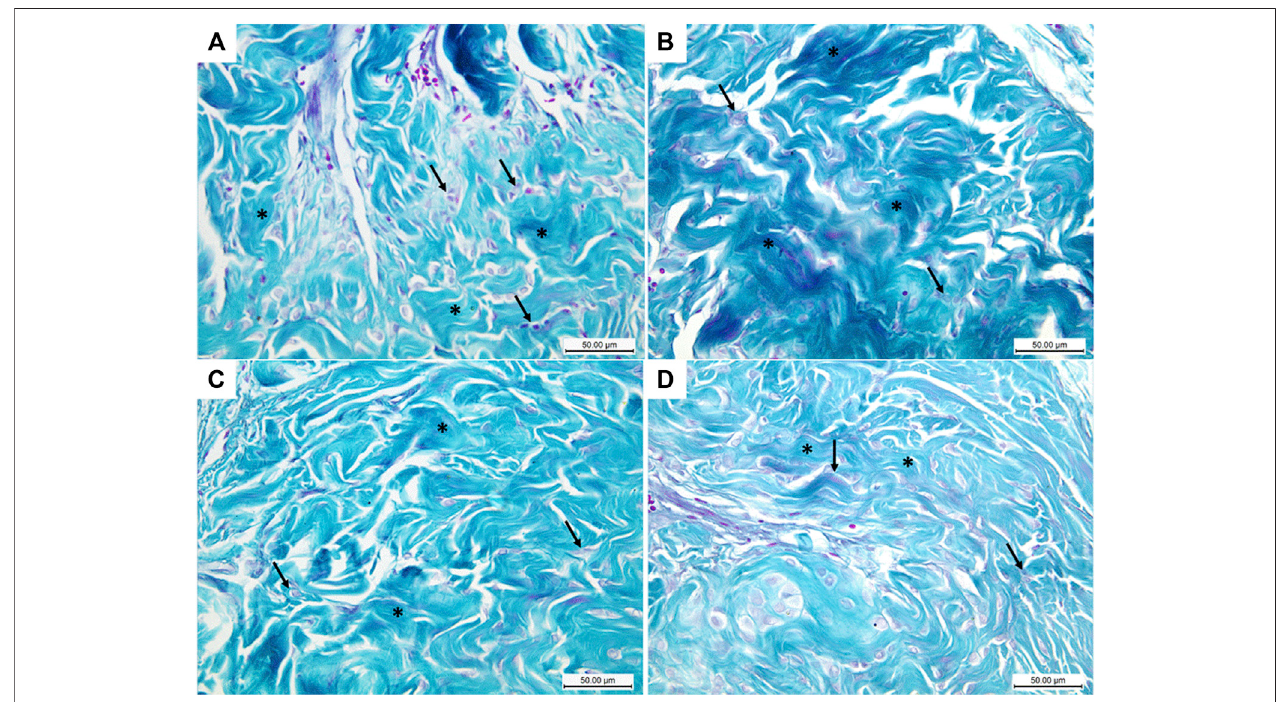
FIGURE6| HistologicaltransversesectionsofthepenisesofallratsinallgroupsstainedwithMassontrichromestain;blueandtheredcolorsindicatecollagenand smooth muscles, respectively. The diabetic rats showed increase collagen expression (B) in comparison to the control rats (A) . Collagen expression in groups III and IV (C) and (D) , respectively, greatly resembles its expression in the control group (A) . Masson trichrome X400. Scale bar: 50 μ m.